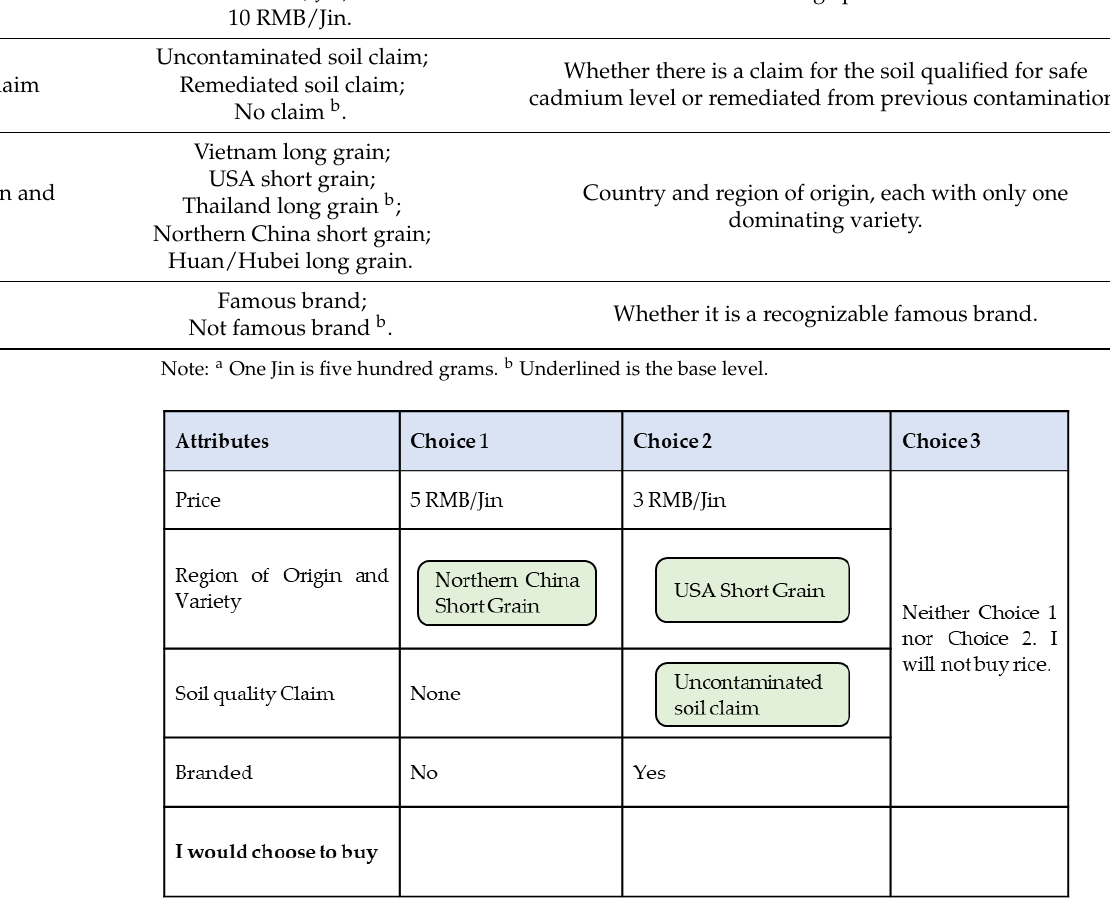
Figure 1. A sample of the choice sets presented to respondents.